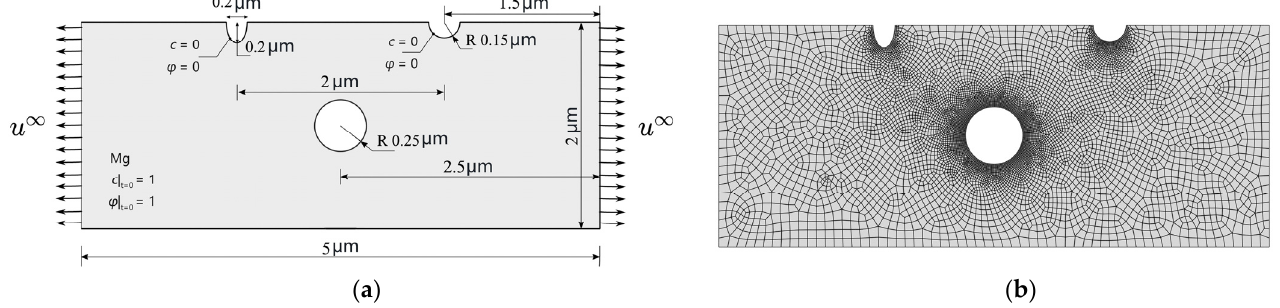
Figure 7. Schematic of the rectangular Mg crystal: ( a ) geometry with initial and boundary conditions for c and ϕ ; ( b ) finite element mesh.